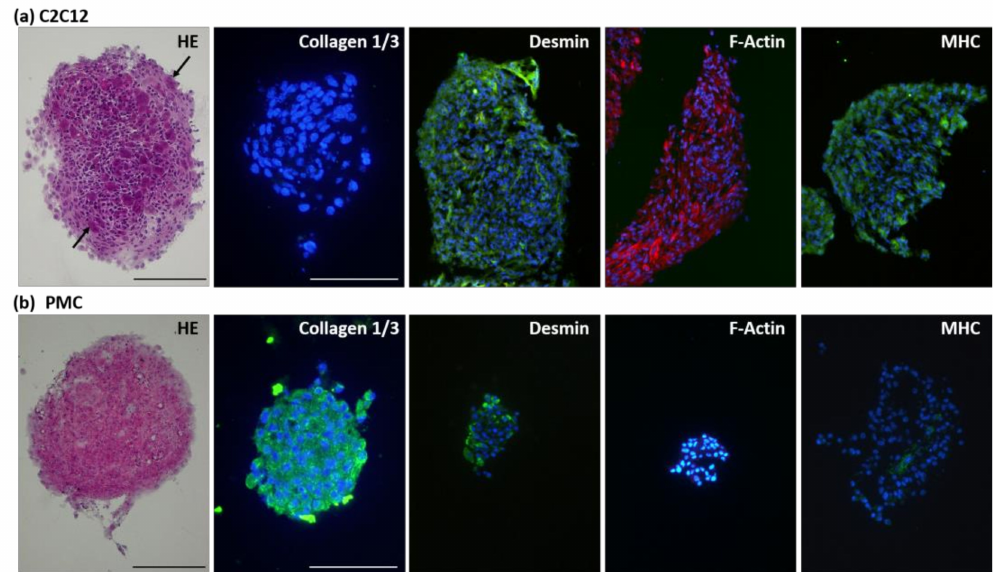
Figure 3. Histological analysis of the myospheres. After 7 days of cultivation, spheroids of C2C12 ( a ) and PMCs ( b ) were frozen and sectioned. Staining with Hematoxylin and Eosin (HE) allows for an overview regarding myosphere structure, arrows point to syncytia in C2C12 spheroids. The ECM proteins collagen 1/3 as well as the myogenic proteins Desmin, F-Actin, and Myosin heavy chain (MHC) were analysed via immunofluorescence staining; cell nuclei were stained with DAPI. Collagen 1/3 expression was detected in porcine spheroids only. All three myogenic markers were clearly detected in the C2C12 spheroids. In PMC spheroids only Desmin was widely expressed, whereas MHC expression was low and F-Actin seemed to be absent. Scale bar: 200 µ